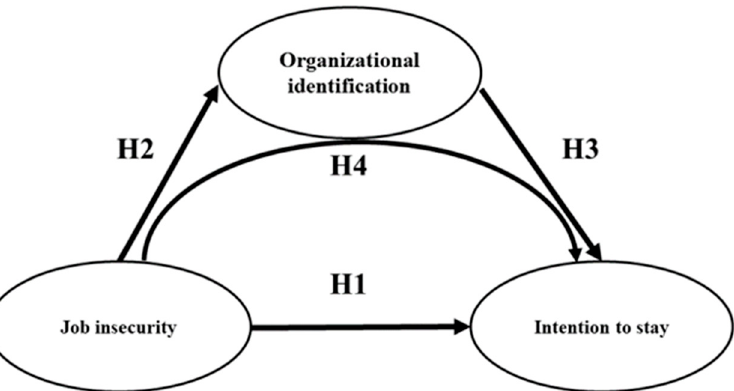
Figure 1. Conceptual model of the hypothesized relationships among job insecurity, organizational identification, and intention to stay.